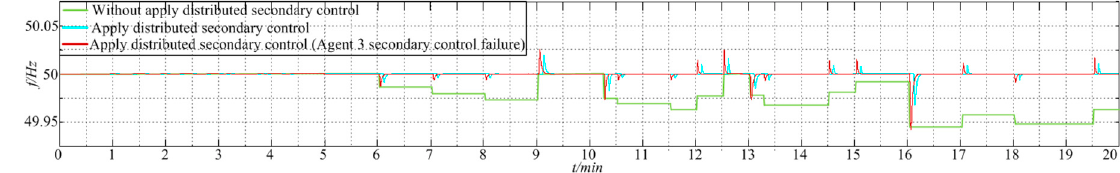
Figure 8. MG frequency.